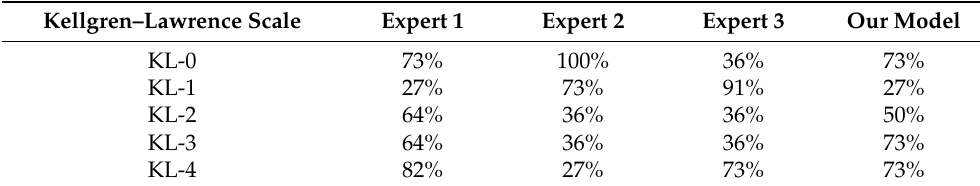
Table 3. Model performance comparison with expert assessment.